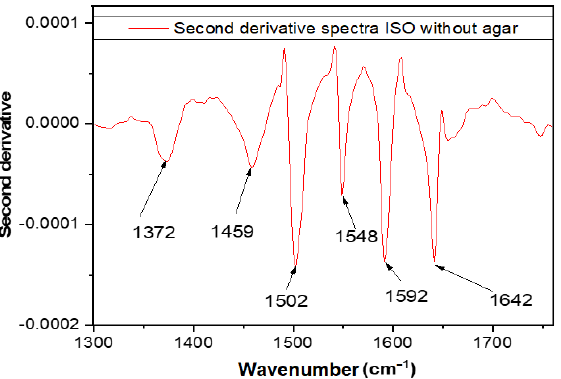
Figure 8. The ATR-IR absorption spectrum attributed to the 1300–1800 cm − 1 region for the ISO SS strain from which the agar-agar spectrum was extracted [28]. Table 5. Positioning and assignment of the bands presented in the ATR-IR spectra characteristic of the ISO SS strain from which the agar-agar spectrum was extracted [28]. Wavelength (cm − 1 ).